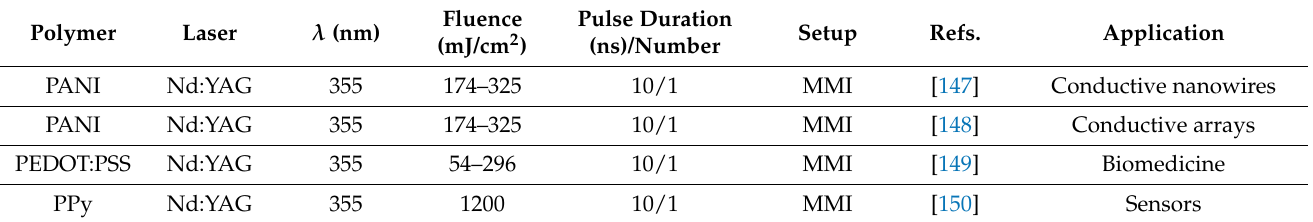
Table 6. Summary of the parameters used to structure conducting polymers using